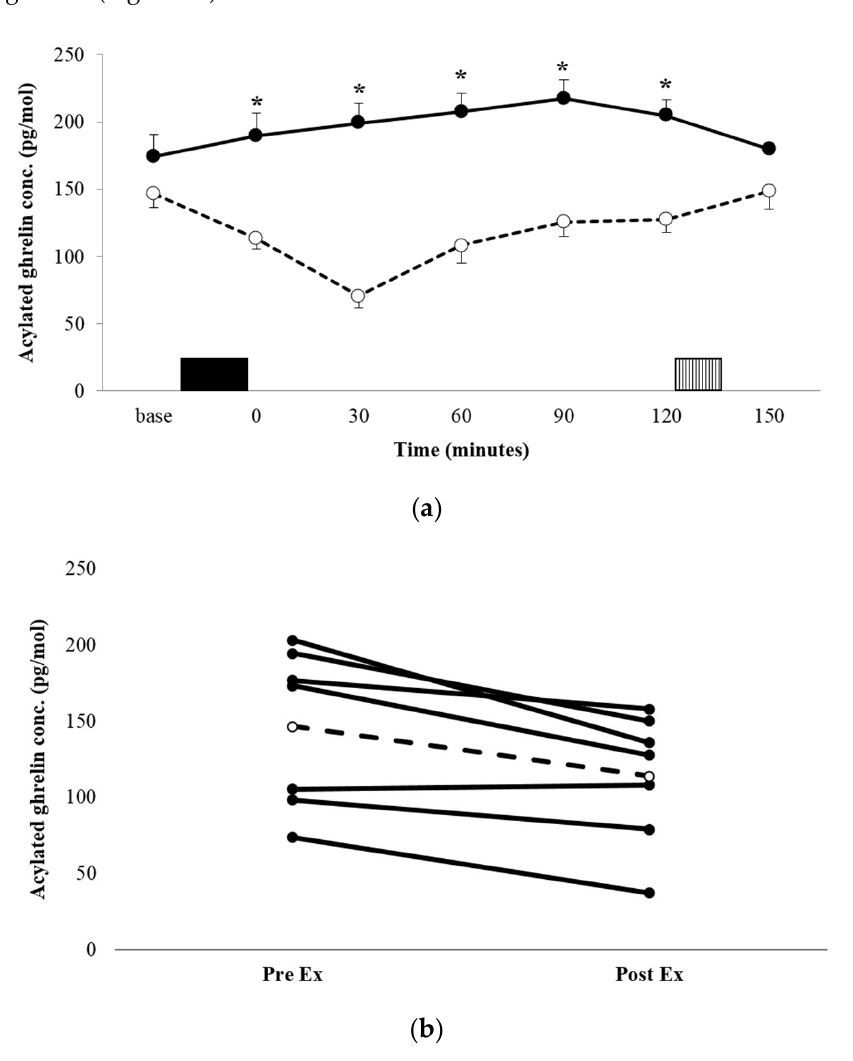
Figure 2. Mean appetite acylated ghrelin concentrations ( a ) for REST ( ● , solid line) and EX ( ○ , dashed line). Solid block represents exercise. Stripe block represents the ad libitum test meal. Values are mean ± SEM. * = exercise significantly different to rest, p < 0.05. Individual responses immediately post exercise ( b ) are also shown for EX. The dashed line represents the mean response.